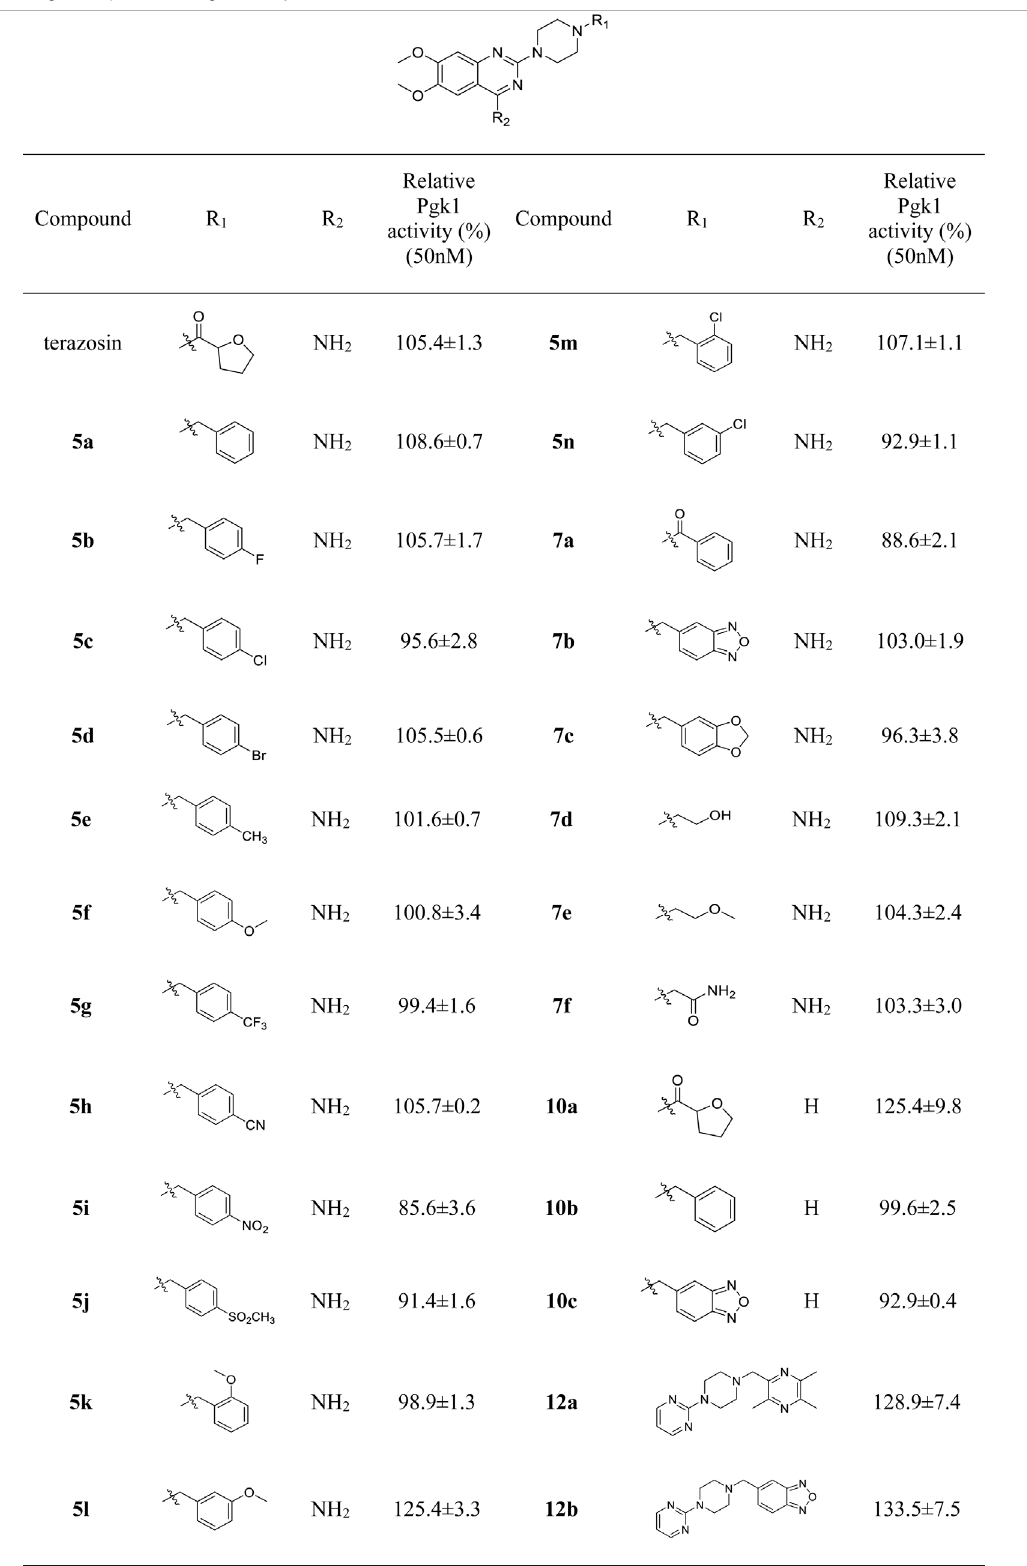
TABLE 2 | Effect of target compounds on Pgk1 activity in vitro